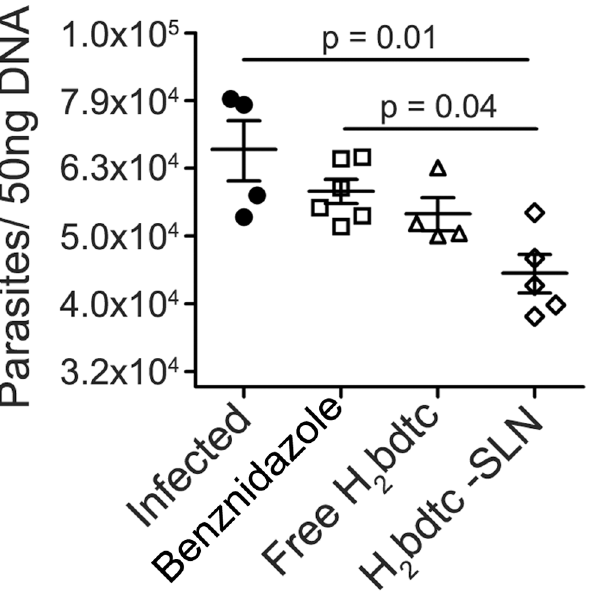
Figure 6. Quantification of the parasites load in cardiac tissues via real-time PCR. The presence of T. cruzi in infected heart tissue mice were analyzed by PCR 22days after infection. Statistically significant differences were showed in the